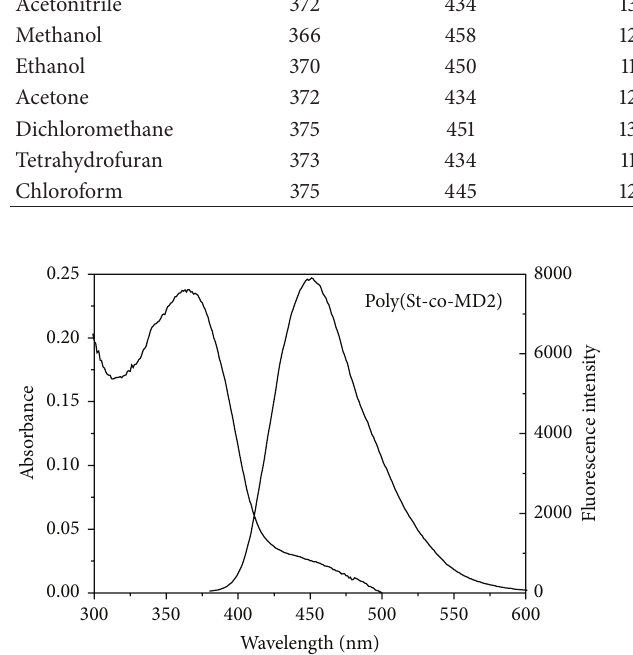
Figure 1: Absorption and fluorescence spectra of poly(St-co-MD2) in solid state as a thin polymer film ( 𝑑 = 40 𝜇